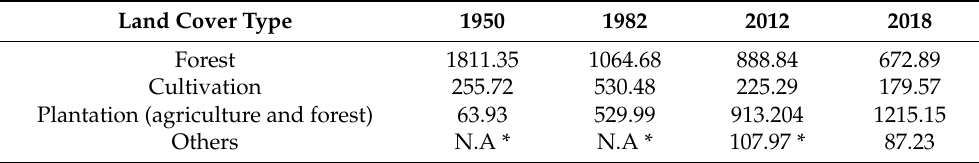
Table 1. Land use and land cover (LULC) of Wayanad district from 1950–2018 (area in sqkm). Land Cover